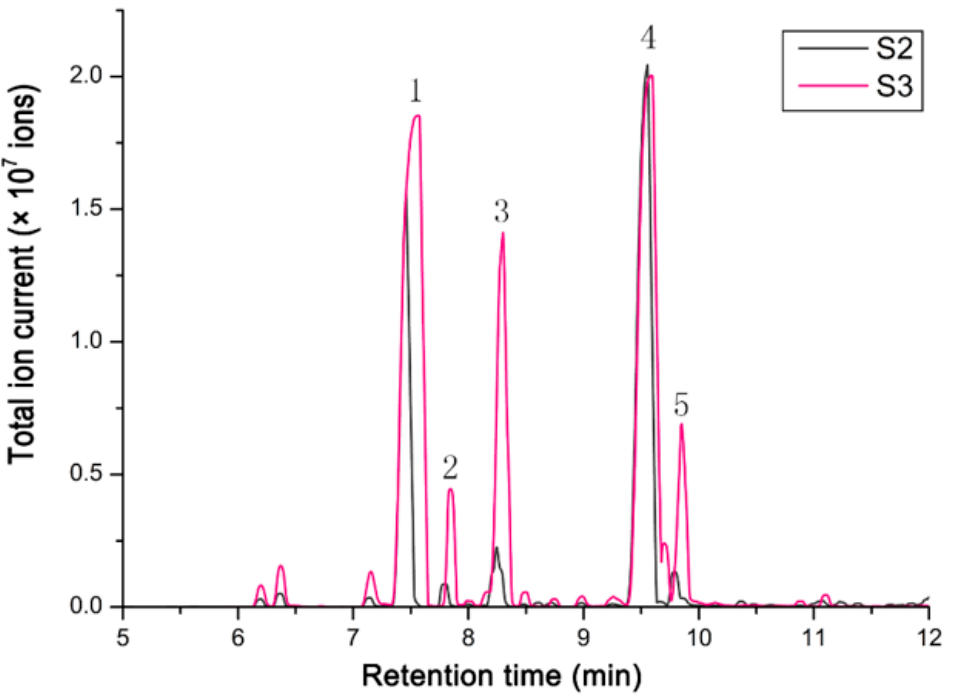
Figure 4. The total ion chromatogram of scent components emitted from the flowers of two different developmental floral stages. The stage of flower buds one day before full bloom (S2) and full-bloom flowers for one day (S3). 1 = β -Pinene; 2 = α -Phellandrene; 3 = D-Limonene; 4 = Linalool; 5 = β - Phellandrene.